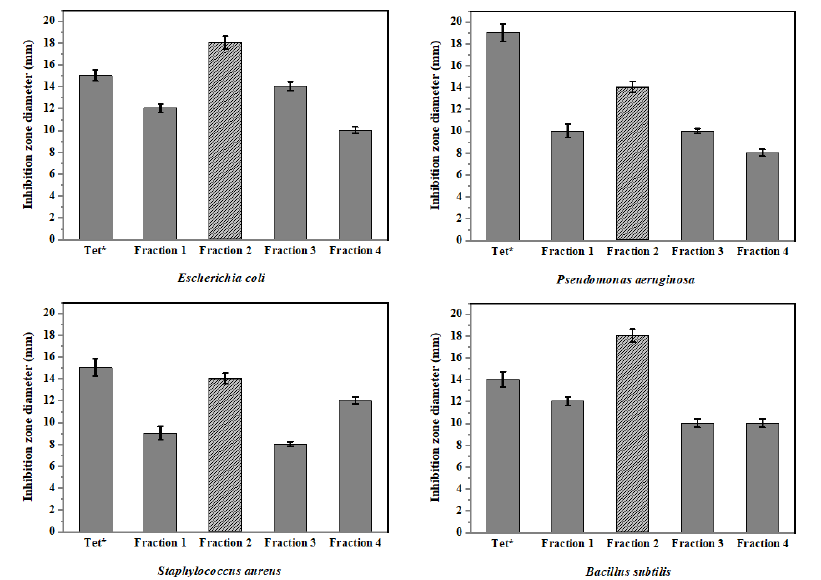
Figure 2. Antibacterial assay by disc diffusion method of the fractions (Figures 1–4) from the selected fungal isolate against tested bacteria. Tet* (tetracycline was used as a positive control). Error bars represent standard error of the means ( n = 3).